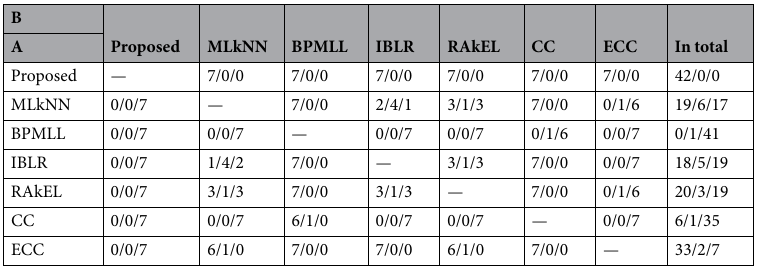
Table 5. Comparison triplets CT(A, B) = (win/tie/loss) by paired t-test between each pair of methods on the original dataset.